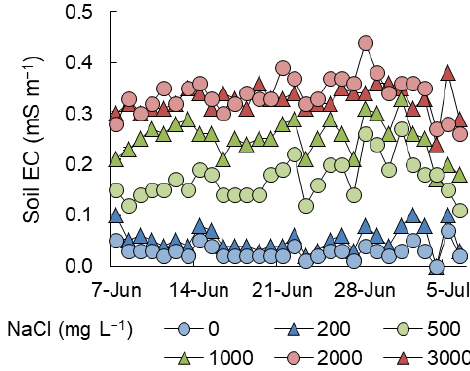
Figure 1. Changes in soil EC from June 7 to July 6, 2016, in Exp. 1 ( n = 1).